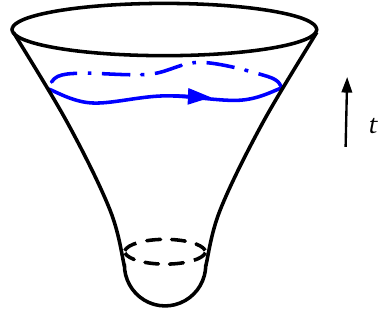
. Time runs upwards. We show the wiggly 2